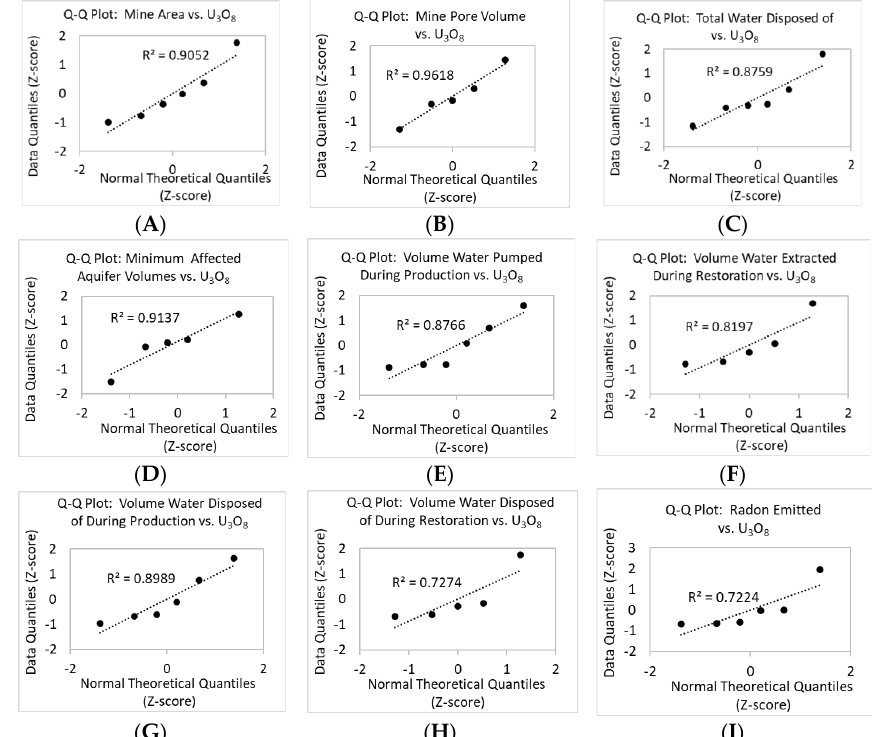
Figure A1. Q-Q plots for ( A ) mine area, ( B ) mine pore volume, ( C ) total water disposed of, ( D ) mini- mum affected aquifer volume, ( E ) water pumped during uranium production, ( F ) water extracted during groundwater restoration, ( G ) water disposed of during uranium production, ( H ) water dis- posed of during groundwater restoration and ( I ) radon emitted as a function of uranium produced (as lb U 3 O 8 ). Plots include data for the six ISR operations listed in Table A1 except for plots ( B ) and ( D ), which include only Kingsville Dome, Mt. Lucas, Palangana Dome, Palangana, and Rosita and plots ( F ) and ( H ), which include only Alta Mesa, Kingsville Dome, Mt. Lucas, Palangana Dome, and